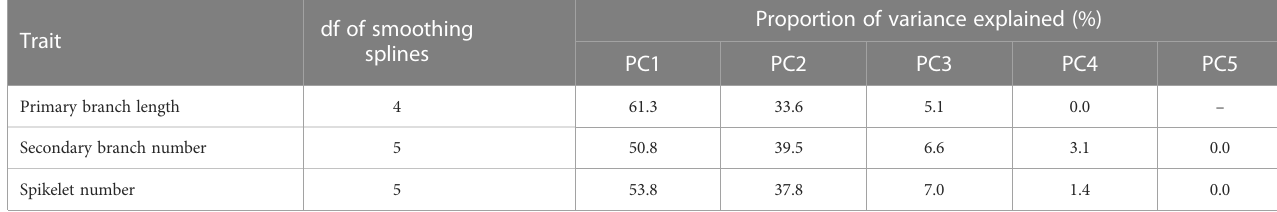
Proportion of variance explained